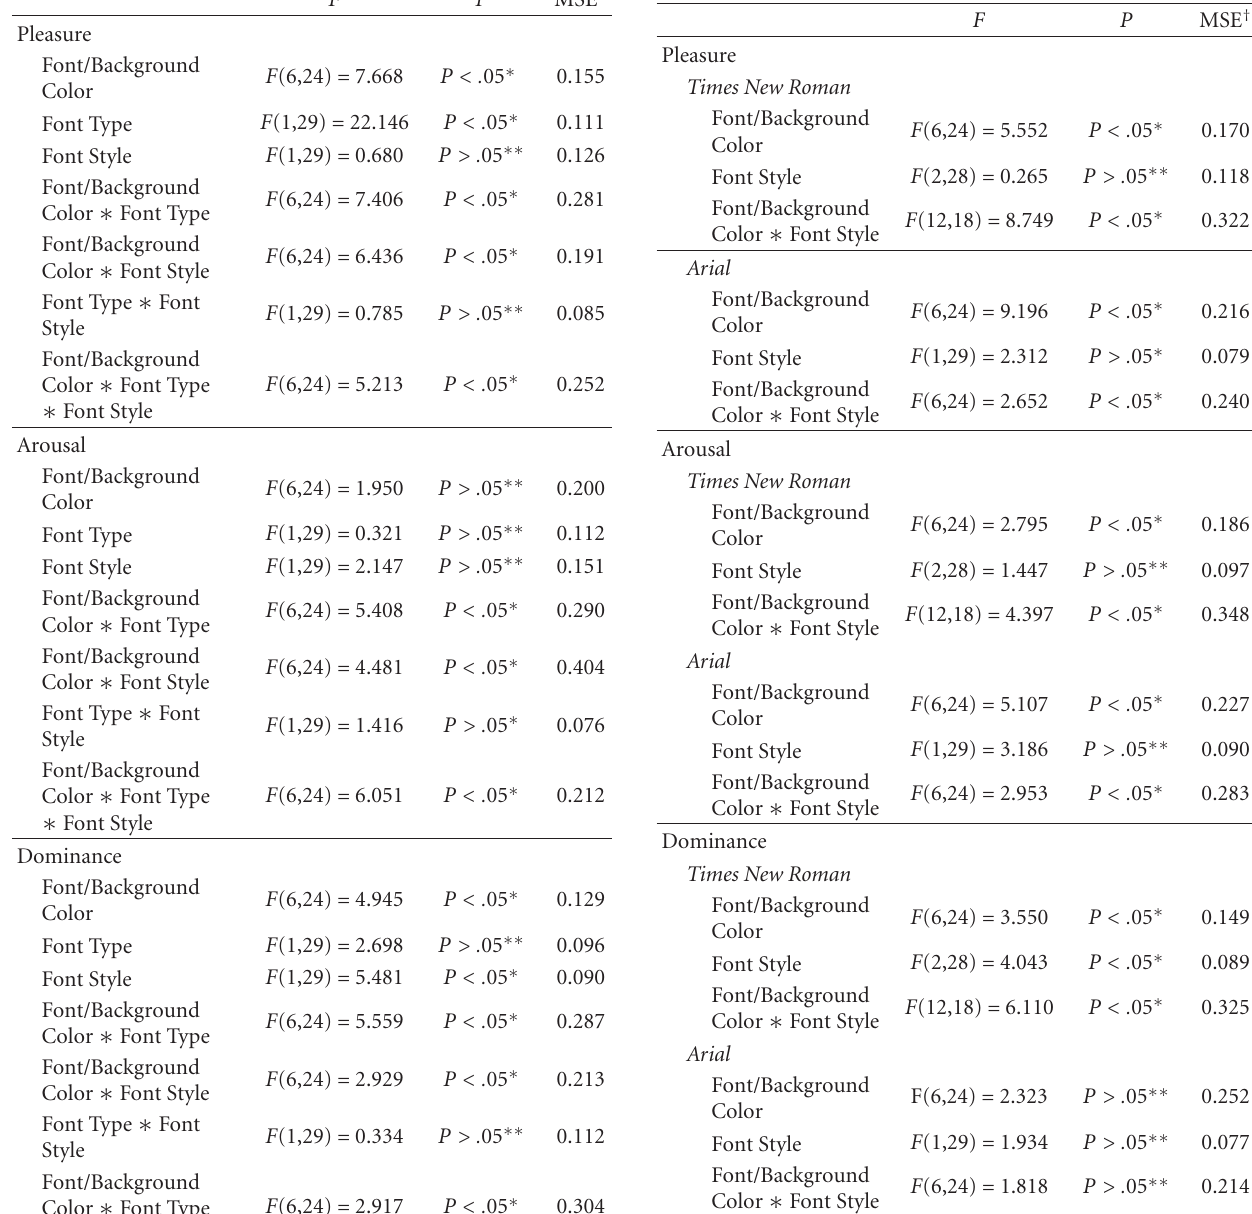
Table 3: Two-way repeated measures ANOVA results for each dependent emotional dimension (PAD) on Times New Roman or Arial with font/background color combinations, font style, and their